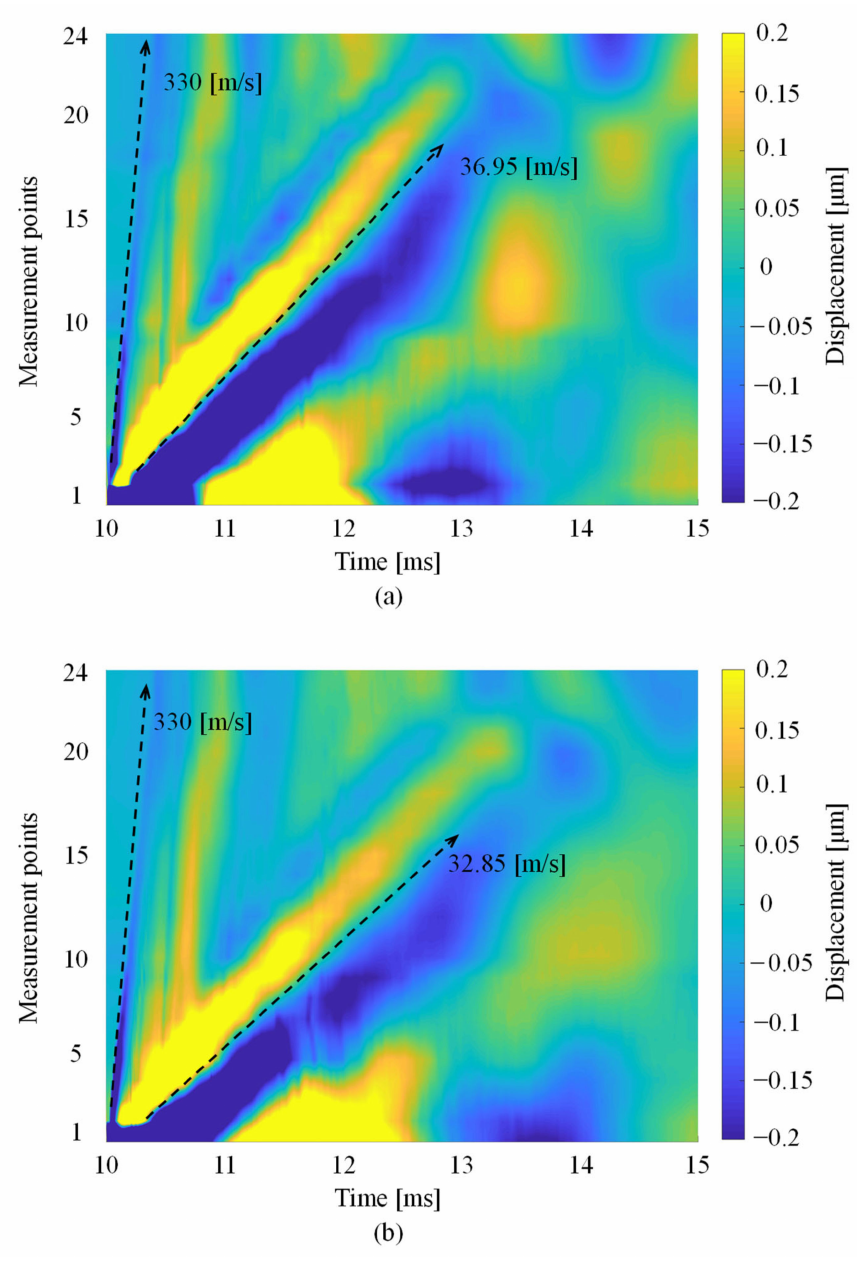
Figure 5. Rayleigh wave propagation on mango 6 on ( a ) Line A at 0 and ( b ) 216